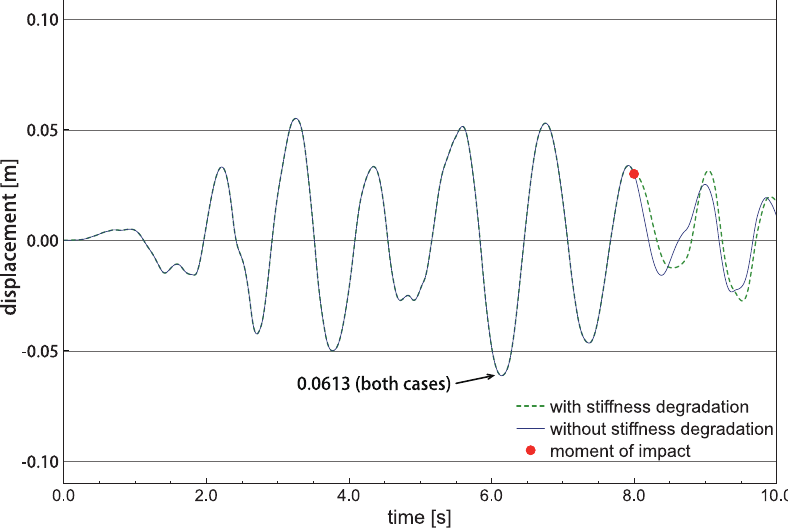
Fig. 12. Displacement time history of the first story of building under the El Centro earthquake with and without considering the degradation of horizontal stiffness for impact at t = 8 s.